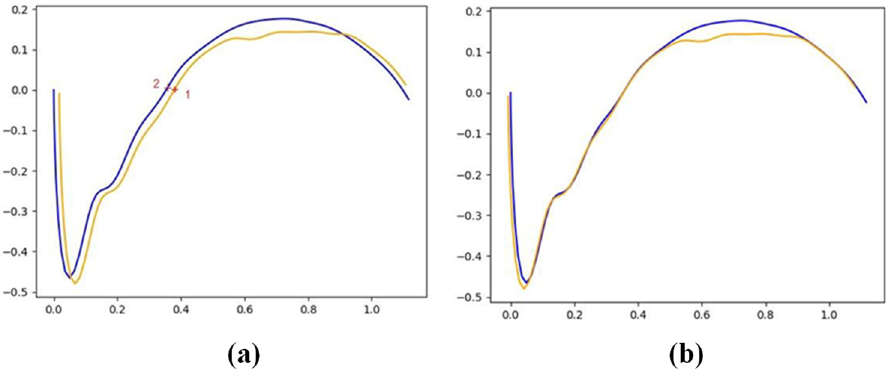
Figure 6. ( a ) Incorrect overlapping of profiles 1 and 2; ( b ) solution after applying best-fitting technique.